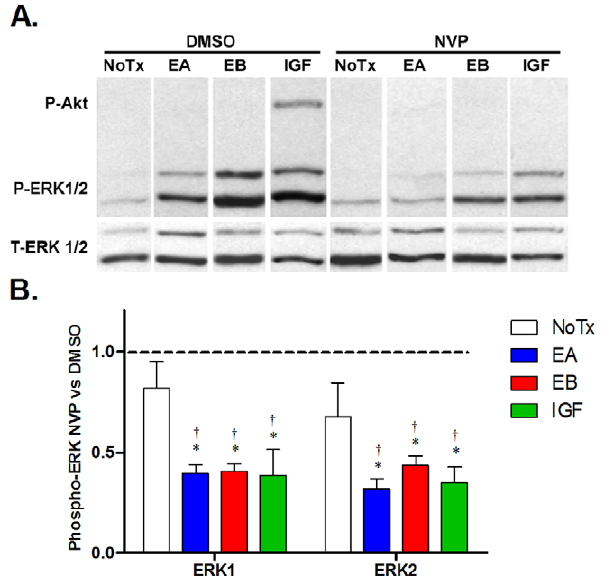
Figure 3. E-peptide ERK signaling requires IGF-IR. A . C2C12 cells were treated as in Figure 2, except the IGF-IR inhibitor NVPAEW541 (NVP, 100 nM) or DMSO was added to cells 90 minutes prior to and during stimulation for 20 minutes. Cells were treated with EA (1 m M), EB (10 nM), or recombinant IGF-I (IGF, 10 nM) as a positive control. EA and EB experiments were conducted separately, and image represents one sample from each experiment. B . Quantification of A. Data are presented as the effect of NVP on ERK phosphorylation: (P/T-ERK of NVP treated)/(P/T-ERK of DMSO treated cells). NoTx bands were used to compare between experiments. Bars represent means 6 s.e.m. of N=3